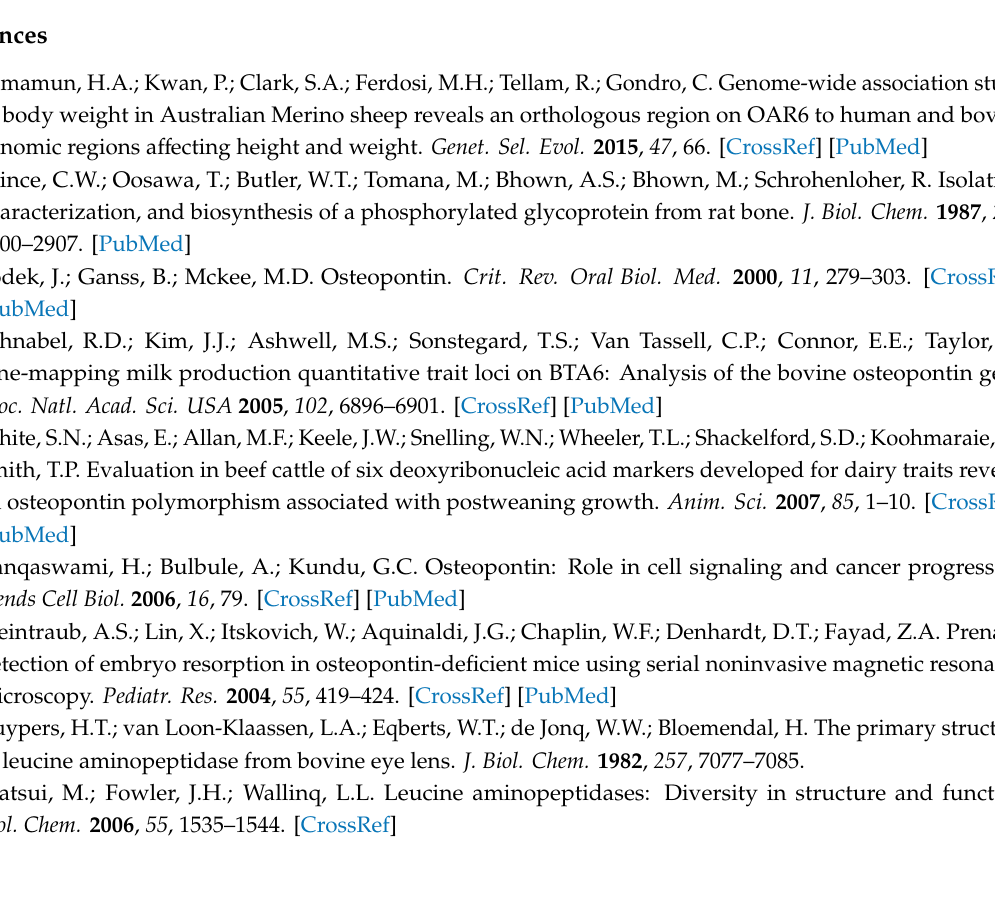
Figure S1: The SPP1 gene SNPs and restriction recognition sites of sheep. The underlined for primers, the red font for restricted recognition sites, Figure S2: The LAP3 gene XM_012179698.3:c.232C > G substitution and its restriction recognition site of sheep. The underlined for primers, the red font for restricted recognition site, Figure S3: The LAP3 gene XM_012179698.3:c.1154C > T substitution and its restriction recognition site of sheep. The underlined for primers, the red font for restricted recognition site, Figure S4: The LCORL gene XM_027970888.1:c.-1096T > C substitution and its restriction recognition site of sheep. The underlined for primers, the red font for restricted recognition site, Figure S5: The LCORL gene XM_027970888.1:c.2162A > C substitution and its restriction recognition site of sheep. The underlined for primers, the red font for restricted recognition